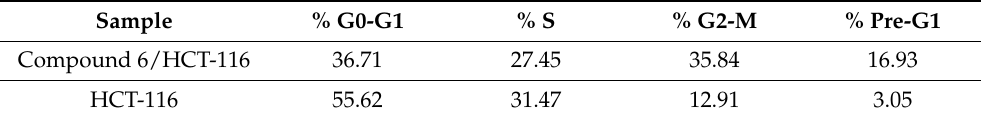
Table 2. Flow cytometric analysis of HCT-116 cells’ cell cycle after compound 6 ’ treatment.